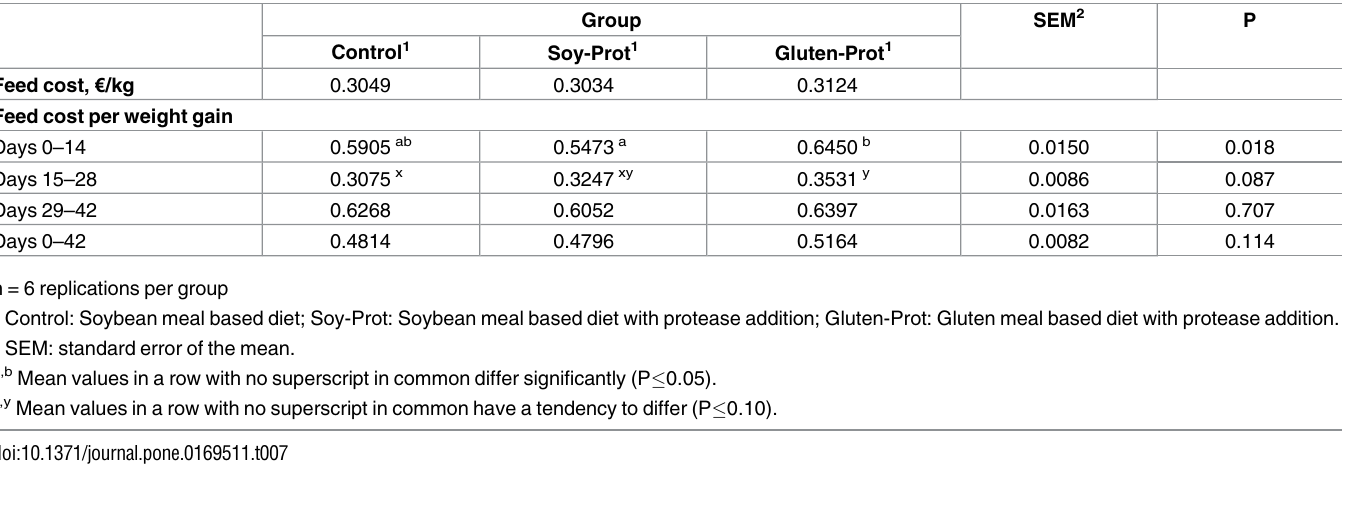
height, crypt depth and villus height to crypt depth ratio in the duodenum, jejunum and ileum Table 7. Influence of diets on feeding cost of broiler